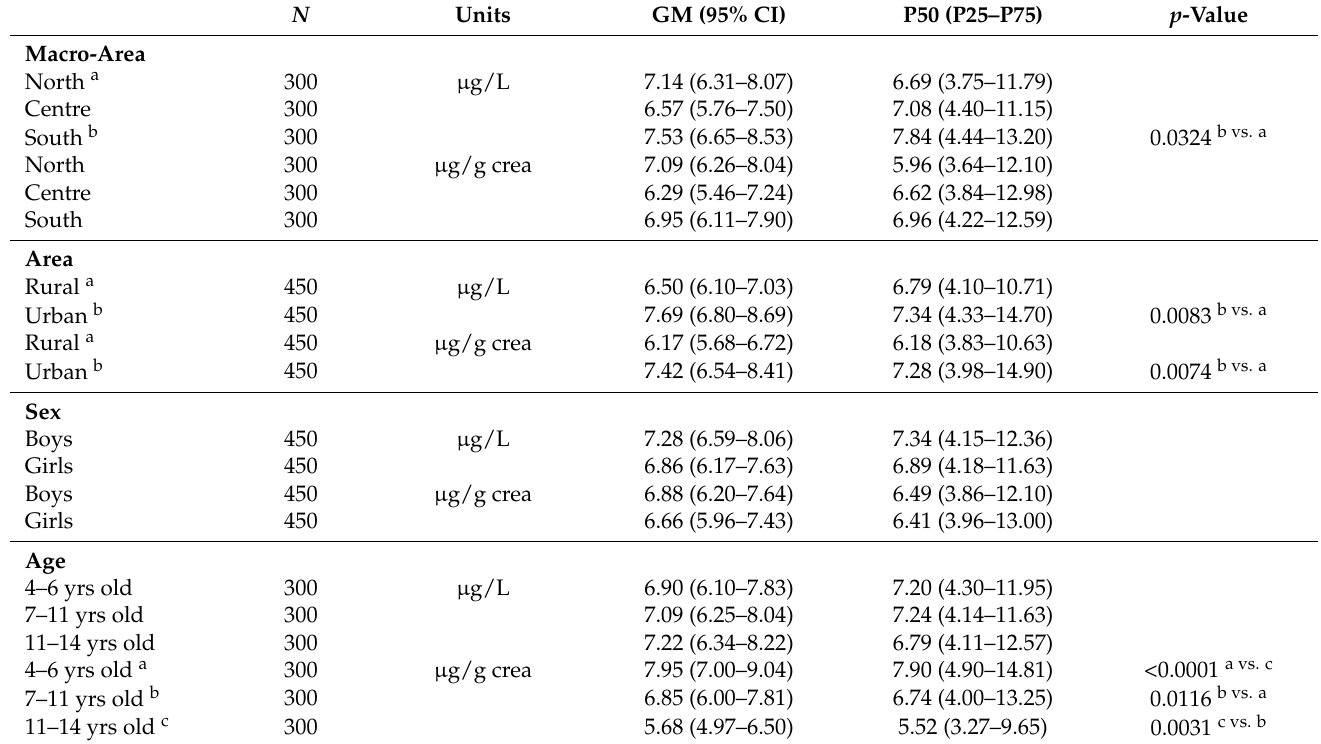
Table 2. BPA levels in urine samples of Italian children stratified by macro-areas, areas, sex and age. The geometric mean (GM) with the 95% CI and the median (P50) with the interquartile range (P25–P75) are shown for both unadjusted ( µ g/L) and creatinine-adjusted concentrations ( µ